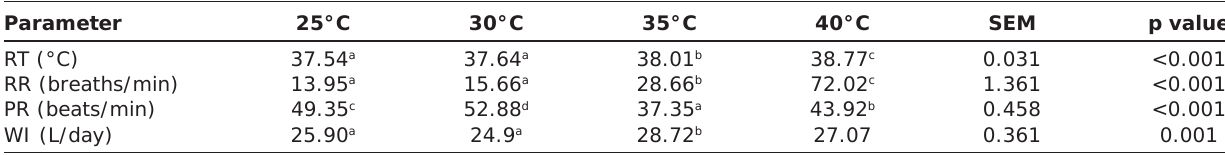
Table-1: Mean±SEM of water intake and physiological parameters at 25°C, 30°C, 35°C, and 40°C in buffaloes. Parameter